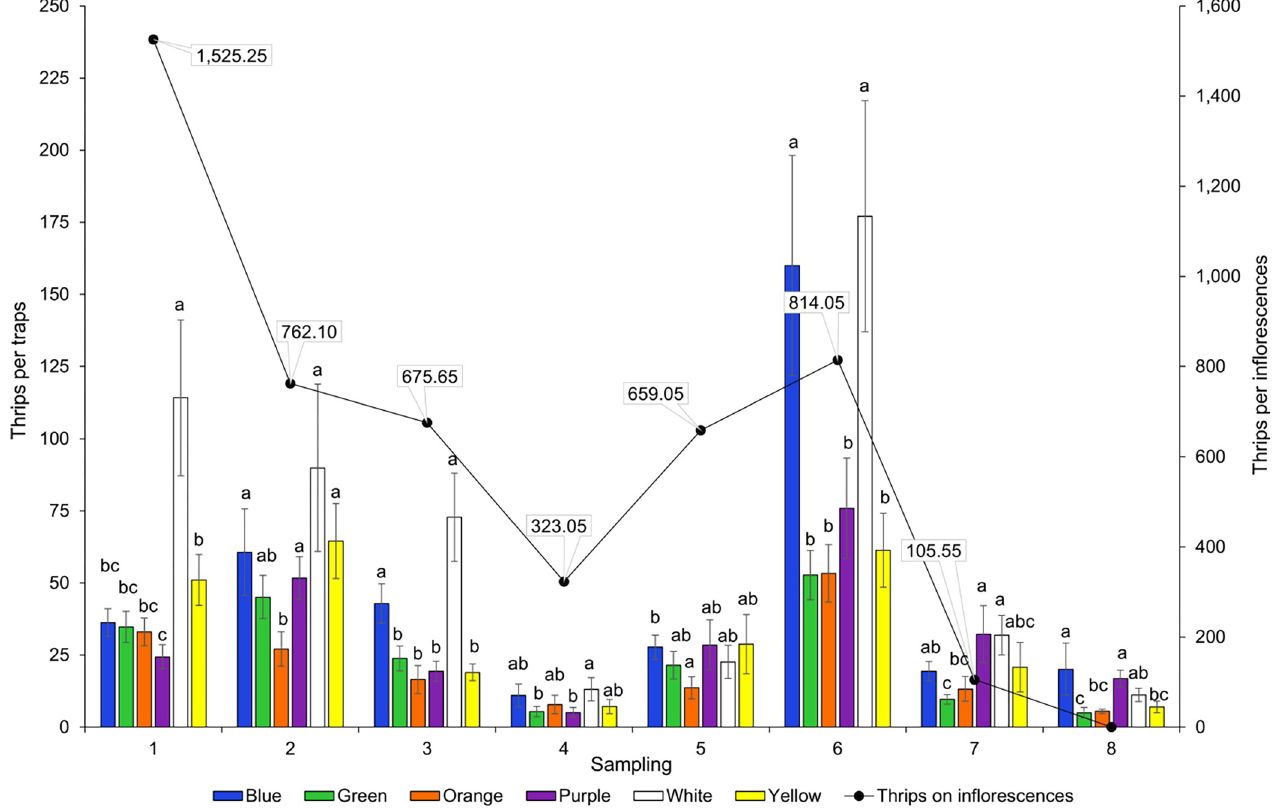
Fig 4. Attraction of thrips adults of the genus Frankliniella to colored sticky traps. Each bar represents the mean catches ( ± SE) of eight replicates to six colors in eight sampling dates (axis-y 1 ). The line shows the mean ( ± SE) thrips adults of Frankliniella in 20 inflorescences in seven sampling dates (axis-y 2 ). Bars capped with the same letter within a sampling date are not significant different (p > 0.05) (untransformed data).